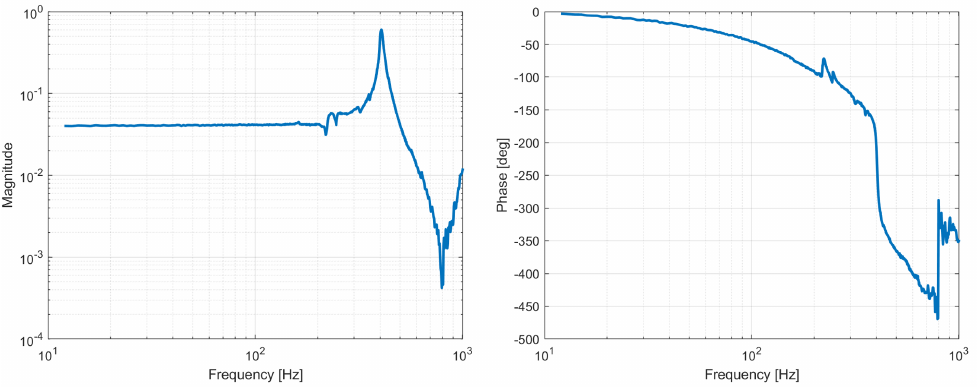
Figure 9. Bode plot of the input current to output force of the final version